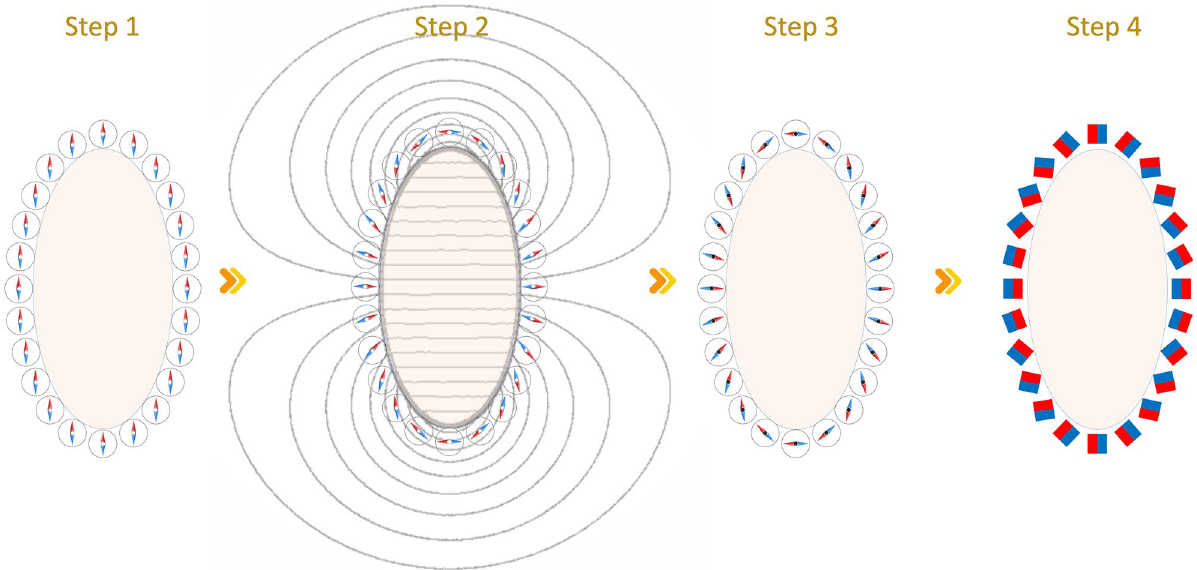
Figure 3. Steps to apply the PMH. In step 1, multiple freely suspended magnetic needles around a desired elliptical region of interest are hypothetically placed. In step 2, a virtual permanent magnet (VPM) of the same ellipticity is set in place and let the magnetic needles rearrange themselves under its influence. In step 3, the magnetic needles are pinned and the VPM is removed. The pinned position of the magnetic needles at step 3 shows the magnetization direction obtained using the PMH. Finally, in step 4, the magnetic needles are replaced with permanent magnets with their magnetization along the magnetic needles’ direction.